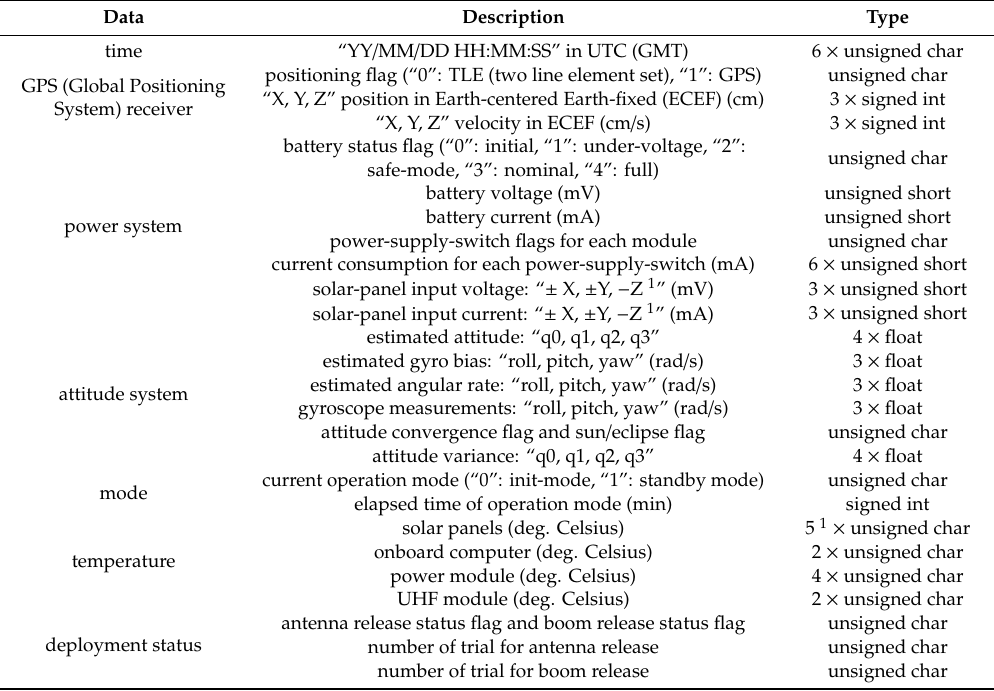
Table 2. Full beacon